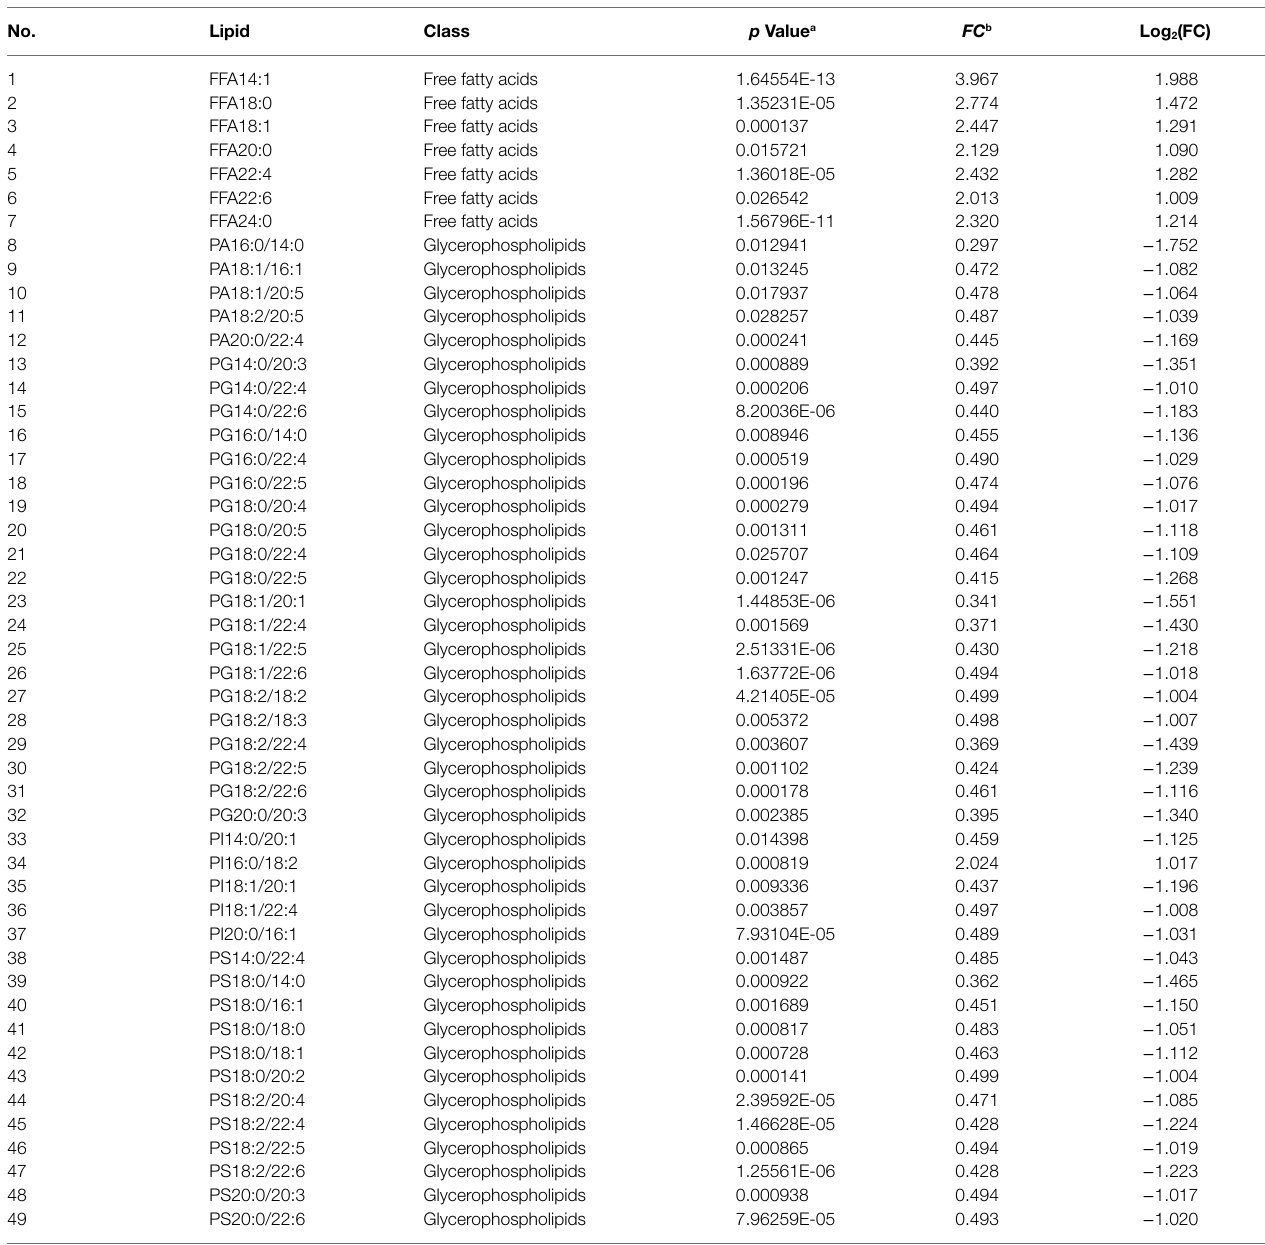
TABLE 10 | Lipids with different levels between male and female